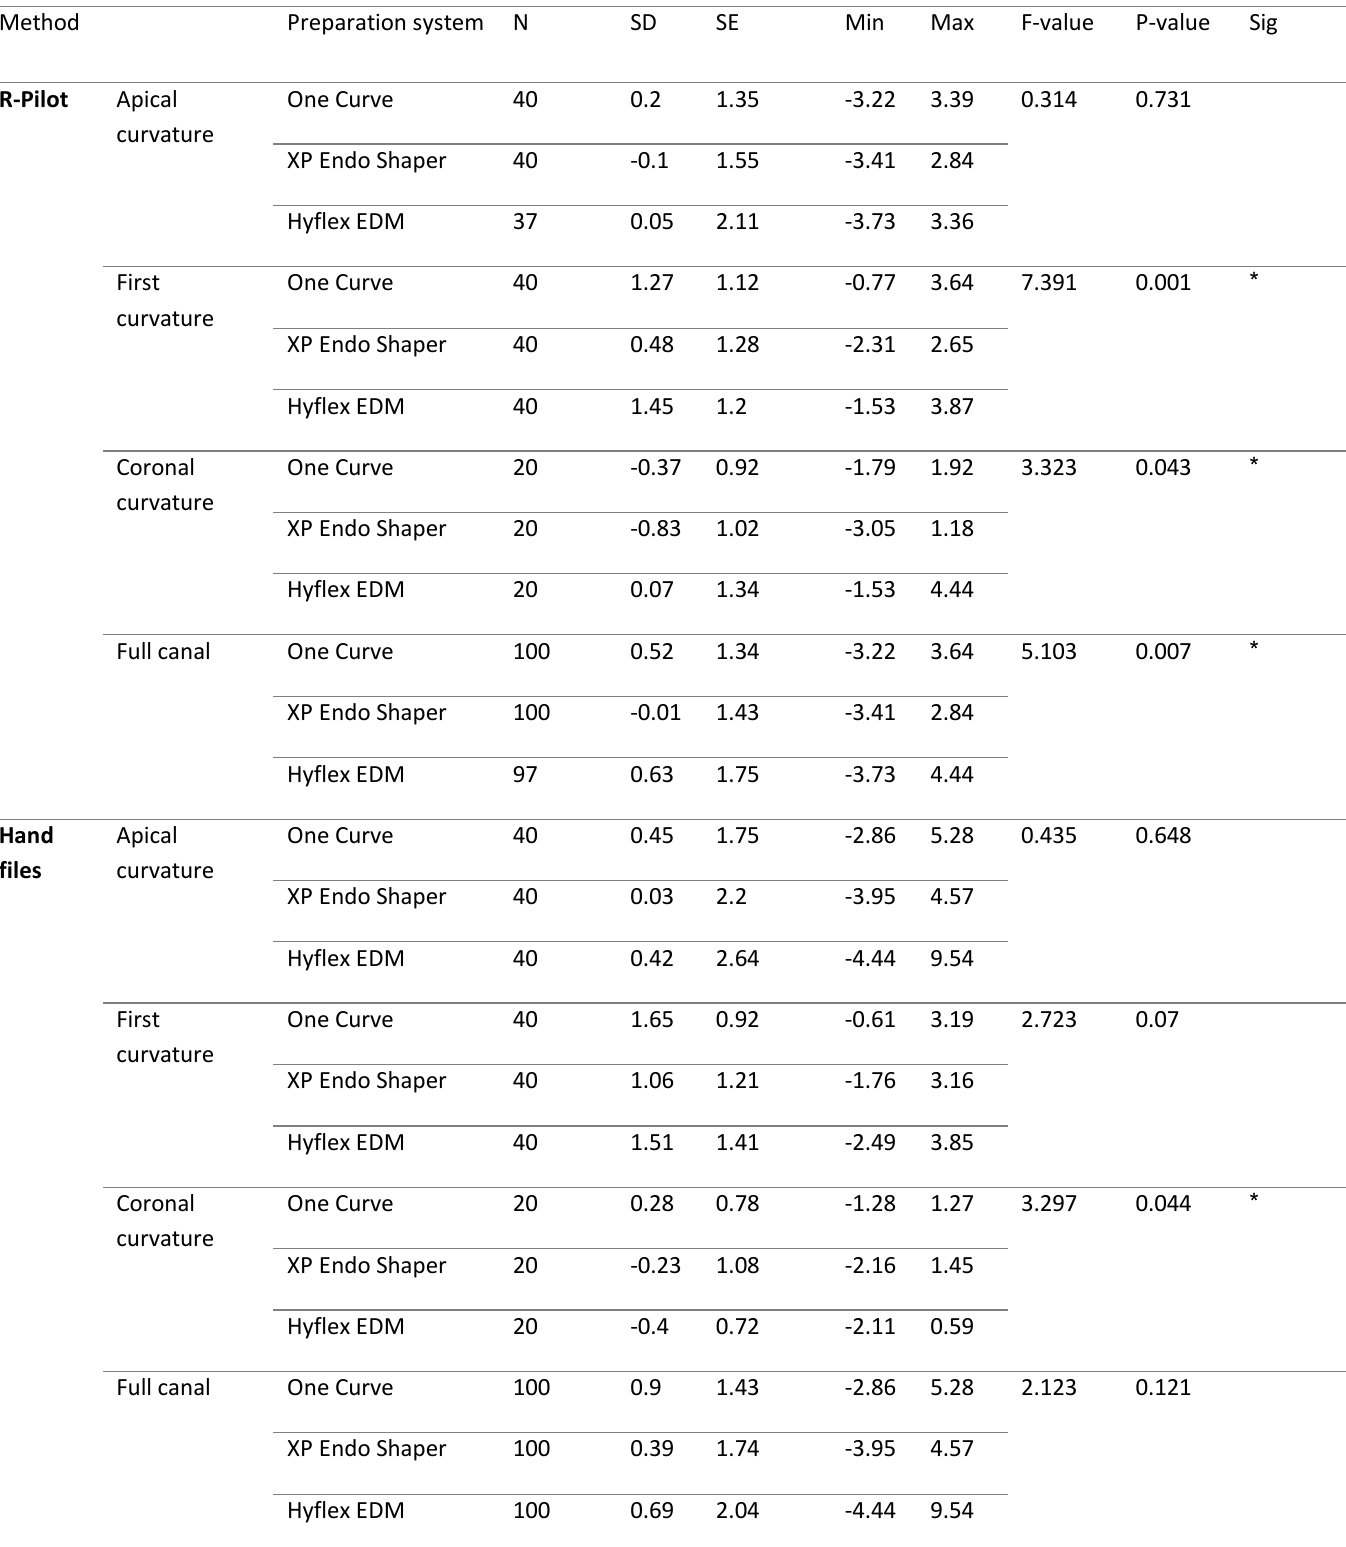
Table 2: studying the deviation from the canal centric ANOVA test. Method R-Pilot Apical curvature